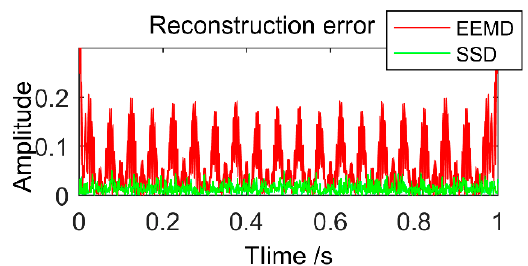
Figure 4. Reconstruction error of simulation signal decomposed by EEMD and SSD.